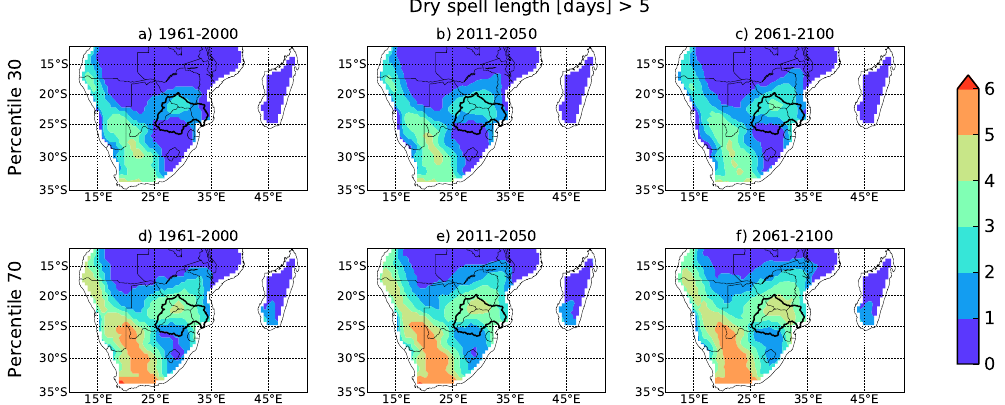
Fig. 1. Changes in the climatology of DJF frequency of occurrence of dry spells longer than 5days. (a) – (c) show the 30th percentile. (d) – (f) show the 70th percentile. From left to right panels, the changes in dry-spell frequency climatology are shown along different time slices in the RCM runs (1961–2000, 2011–2050 and 2061–2100).